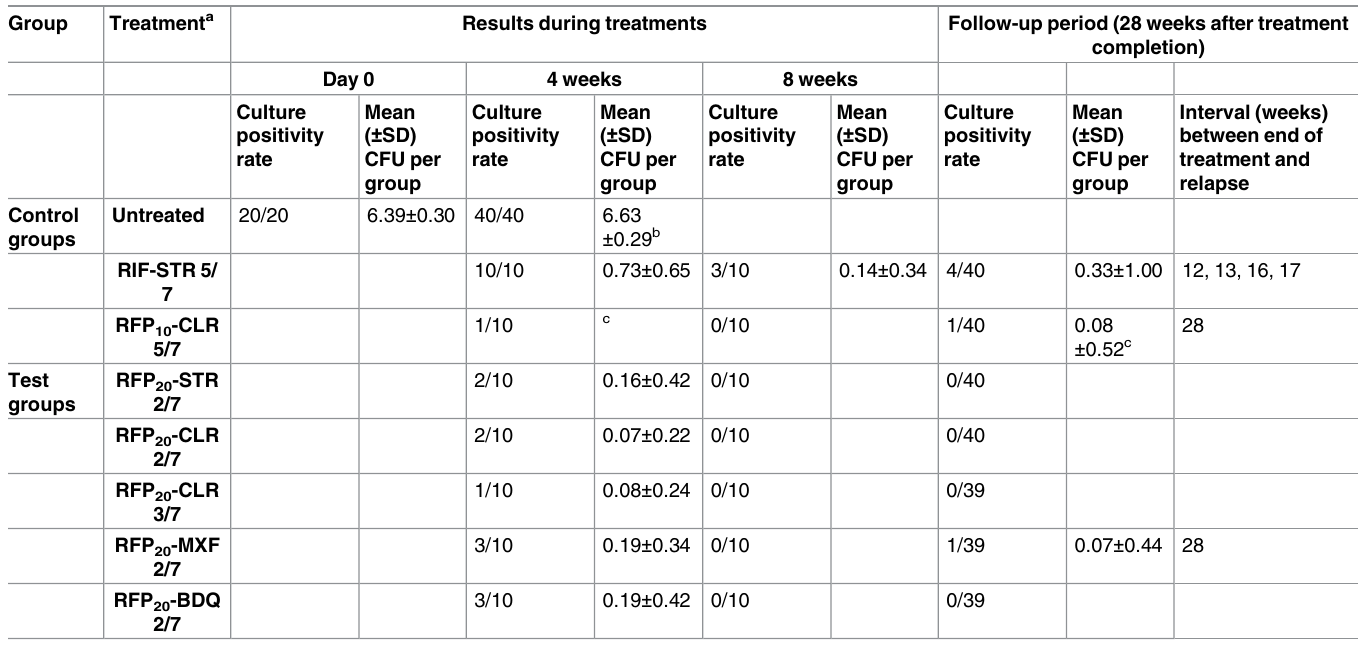
Table 1. Results of footpad cultures during the treatment of mice infected with M . ulcerans and relapse rate after treatment completion.